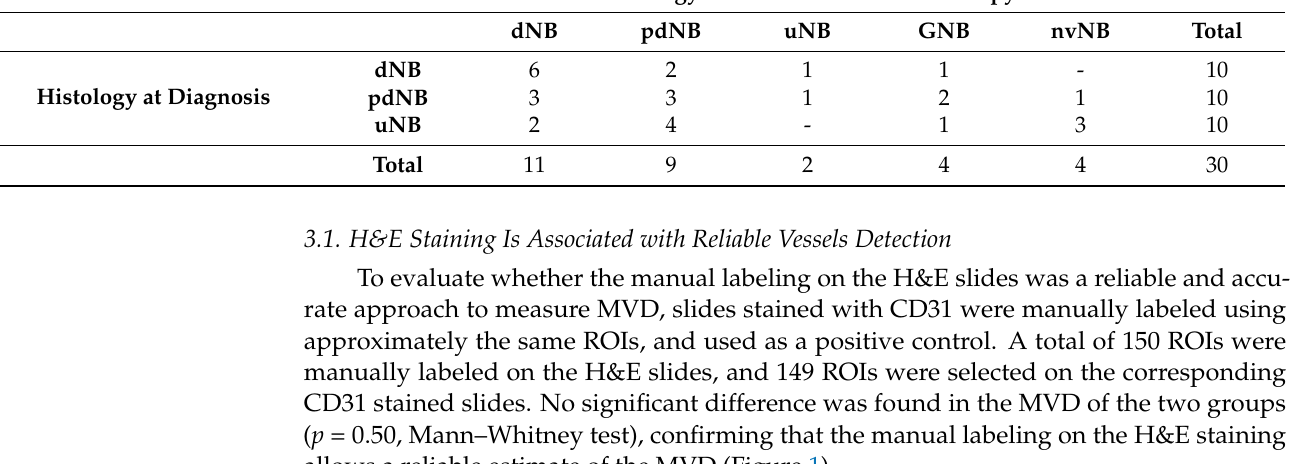
Table 1. Summary of histological subtypes at diagnosis (rows) and after induction chemotherapy (columns) for the entire cohort included in the study ( n = 30). Abbreviations: uNB = undifferentiated neuroblastoma; pdNB = poorly differentiated neuroblastoma; dNB = differentiating neuroblastoma;